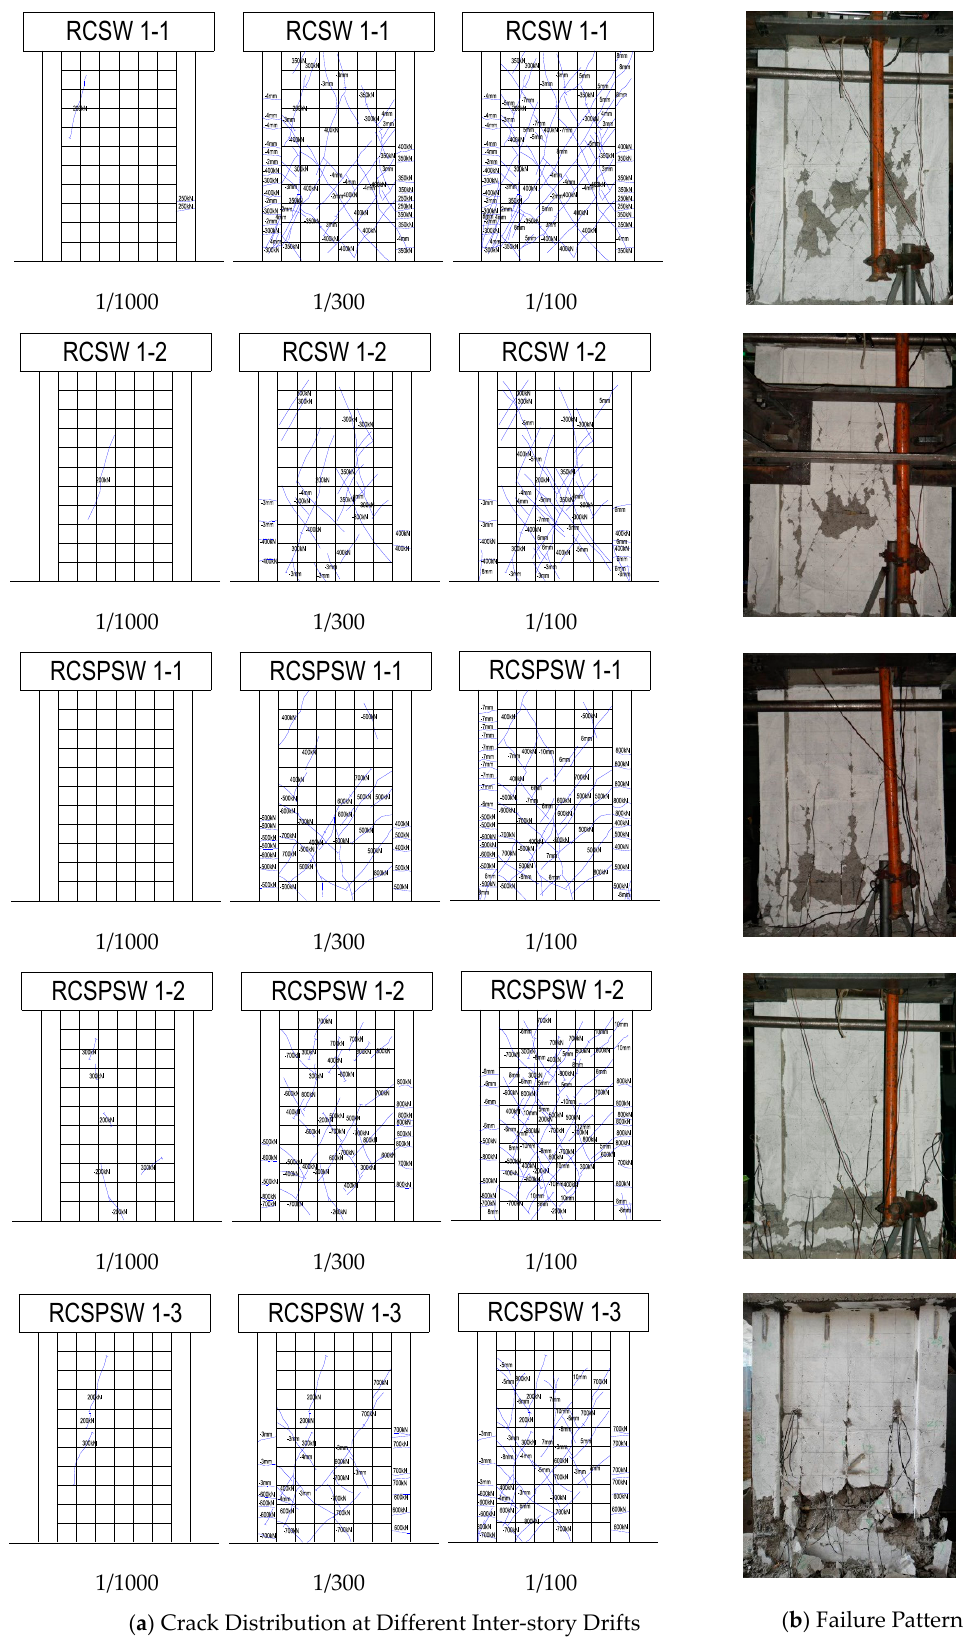
Figure 7. Crack Distributions and Failure Patterns of Specimens with Aspect Ratio of 1.5 ( a ) Crack Distributions at Different Drifts and ( b ) Photograph of Failure Patterns.